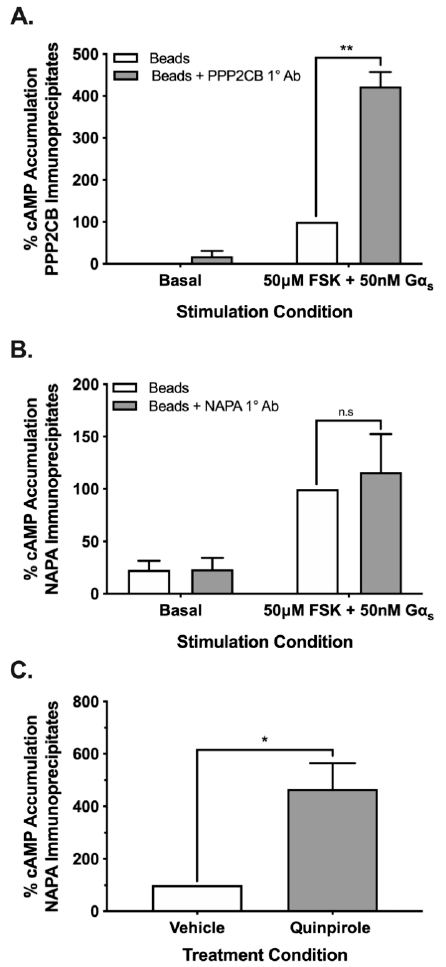
Figure 4. Adenylyl cyclase activity is elevated in immunoprecipitates of interacting partners. Immunoprecipitation of PPP2CB and NAPA resulted in enhanced AC activity in the pulldown product in a treatment-dependent manner. The PPP2CB immunoprecipitate exhibited 4-fold enhancement of AC activity under vehicle treatment conditions ( A ). The NAPA immunoprecipitate exhibited no significant di ff erence in AC activity under vehicle treatment conditions ( B ). Quinpirole pretreatment resulted in a significant 4.5-fold enhancement of AC activity from NAPA immunoprecipitates compared to the vehicle-treated group ( C ). Statistical analysis was performed (t-test), * p < 0.05, ** p < 0.01. Experiments (n = 3) were performed in duplicate with SEM shown.